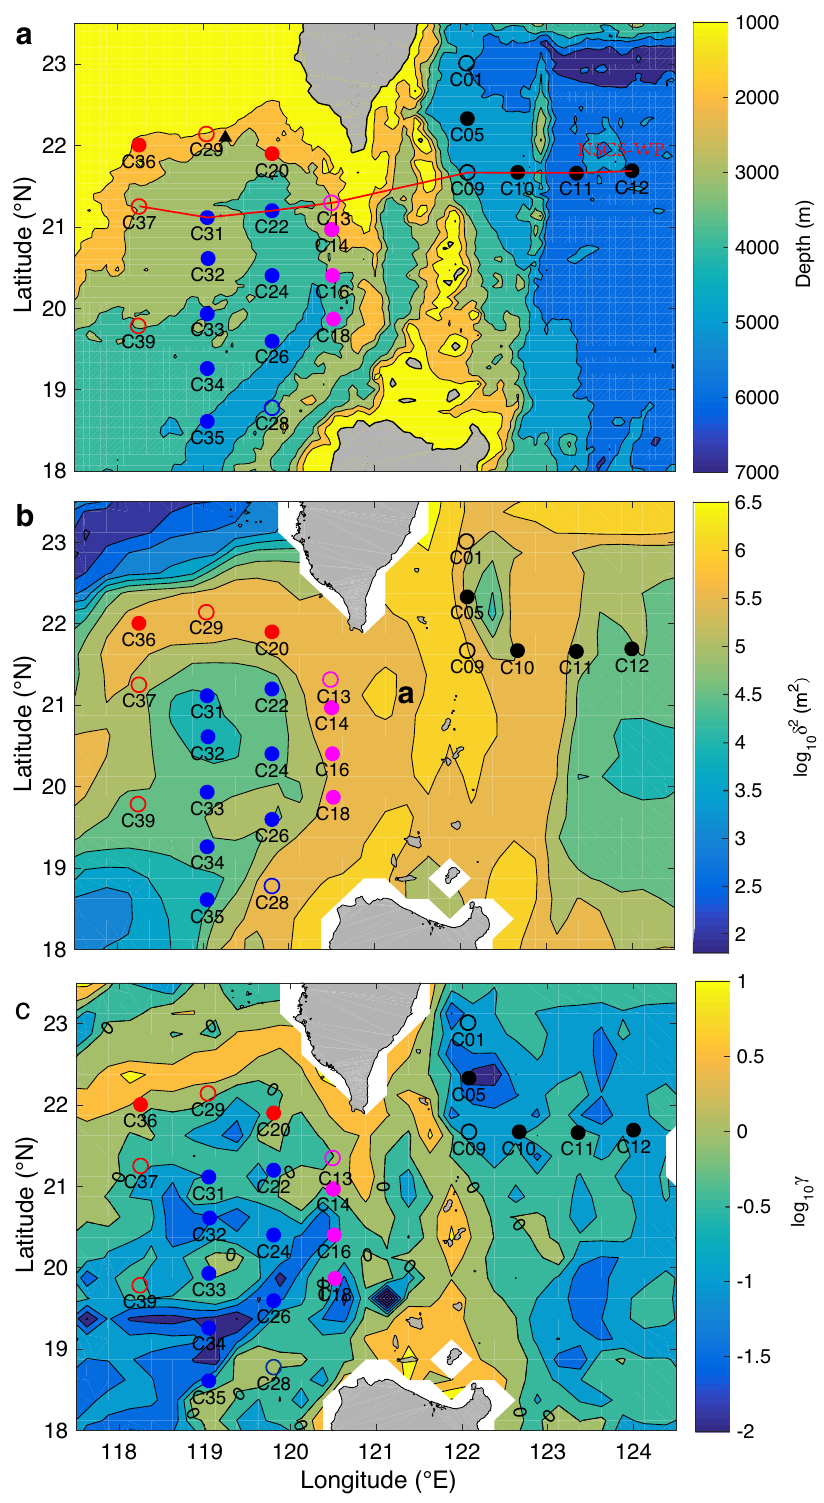
Figure 1. Map of the cruise area in the northeastern South China Sea (NSCS) and West Pacific (WP) showing microstructure measurement stations at the NSCS slope (red dots and circles), NSCS basin (blue dots and circles), and Luzon Strait (LS, magenta dots and circles) with the background topography ( a ), roughness ( δ 2 , b ) and slope criticality ( γ ) for semidiurnal tides ( c ). The red line (in panel a) indicates the cross-section in Fig. 2. Dots and circles represent microstructure profiles taken in 2018 and 2019, respectively. The black triangle near C29 is the station where the moored ADCP was deployed. Figures were plotted using MATLAB R2016b (http:// www. mathw orks.